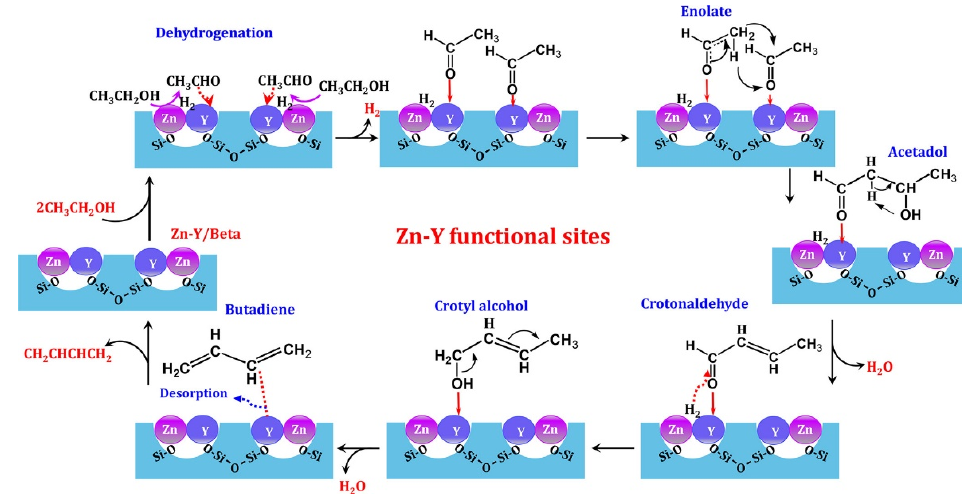
Figure 15. Proposed mechanism of catalytic ethanol conversion into butadiene over the bifunctional Zn-Y/BEA zeolite catalyst. Reprinted with permission from [101]. Copyright 2018 American Chemical Society.